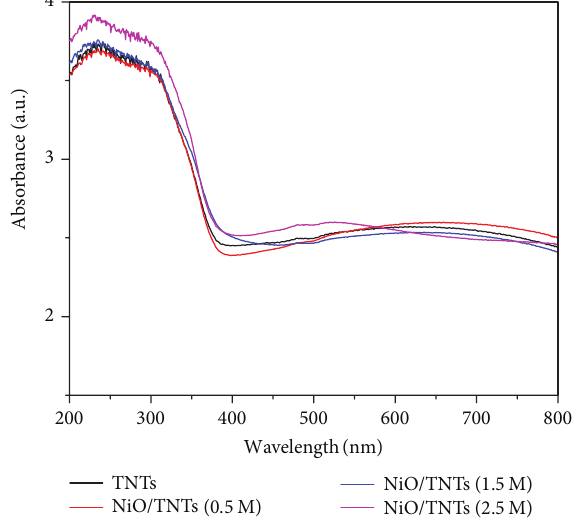
Figure 5: UV-Visible absorption spectra of pure TNTs and different concentrations of NiO/TNTs (concentrations in molarity).